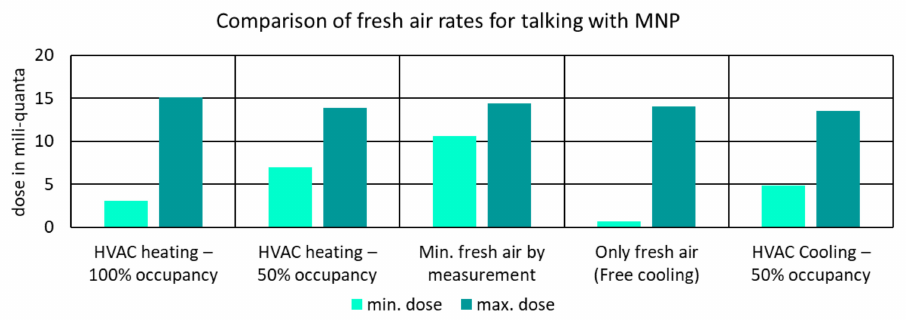
Figure 10. Influence of fresh air and recirculated airflowrate on the amount of exposure for the ICE: min. dose, minimum dose absorbed farther away from the emitter; max. dose, maximum exposure that is absorbed close to the emitter.